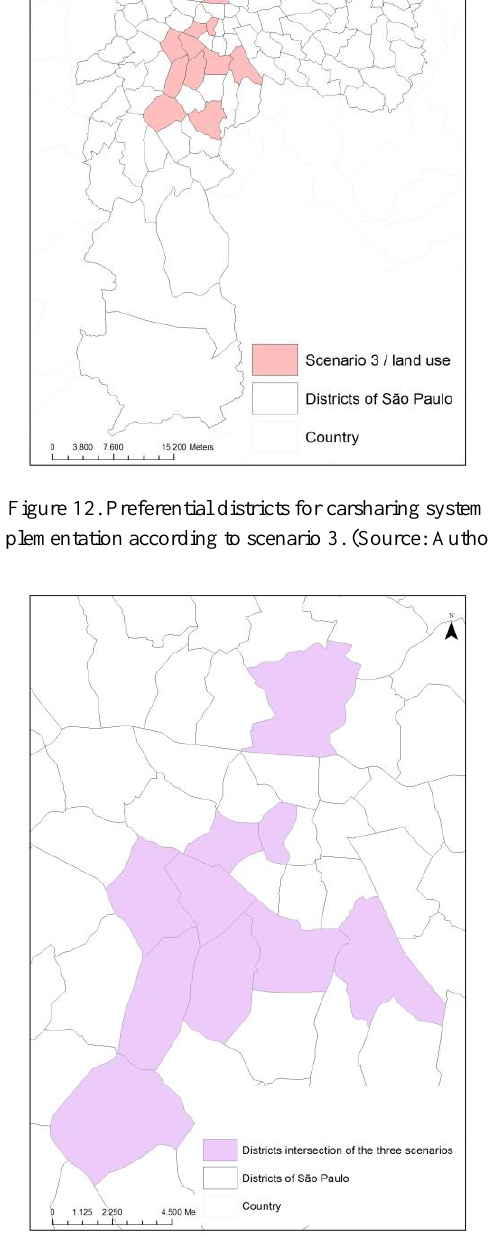
Figure 11. Preferential districts for carsharing system implementation according to scenario 2. (Source: Authors)